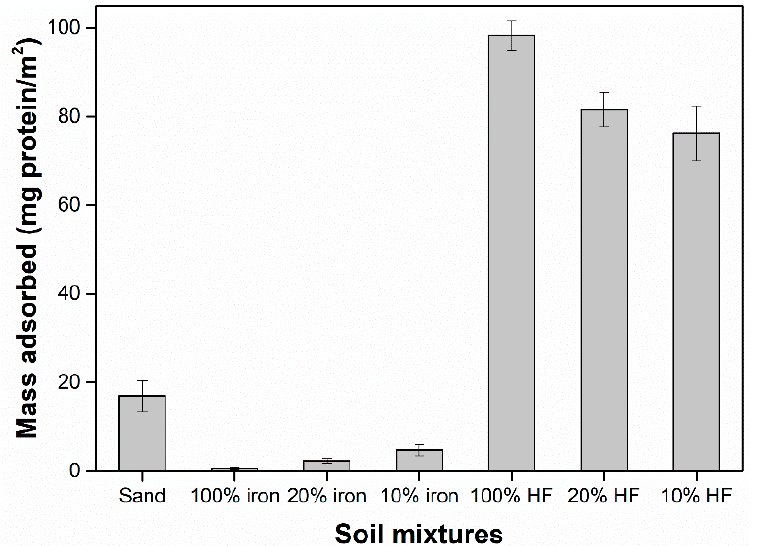
Figure 1. The surface coverage for samples containing sand, mixtures of sand and iron-coated sand (“iron”), and mixtures of sand and hydrophobic-coated sand (“HF”). The initial protein concentration used was 4 mg/mL, with a ratio of 2 mg protein per gram of soil. Surface coverage was calculated by normalizing the amount of total protein adsorbed by the total surface area of each sample. Values shown are averages of three replicates and error bars represent the standard error.